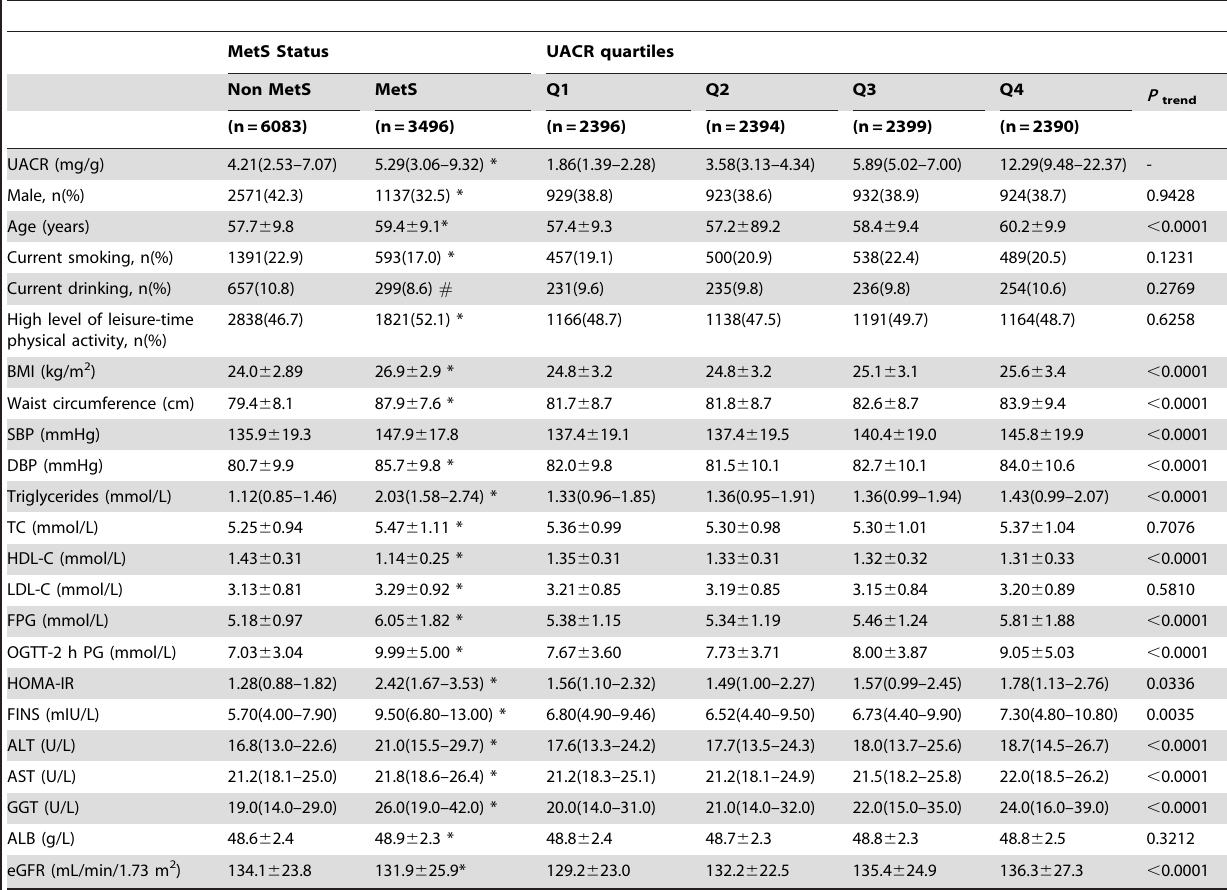
Table 1. General characteristics of the study